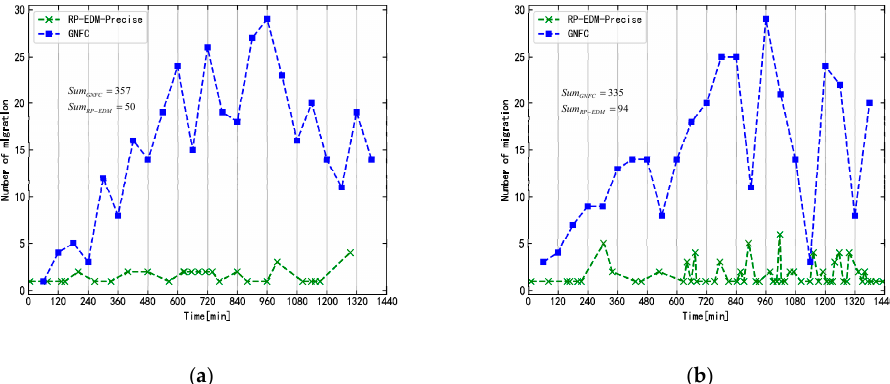
Figure 6. Comparison of the result of RP-EDM and GNFC when serving different amounts of traffic; ( a ) a large amount of traffic and CPU capability of each server is equal to 1000 MIPS; ( b ) a small amount of traffic and CPU capability of each server is evenly distributed from 250 to 300 MIPS.